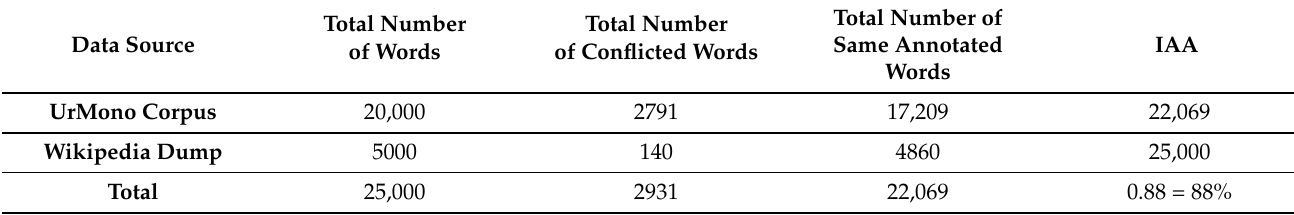
Table 1. Detailed statistics of inter-annotator